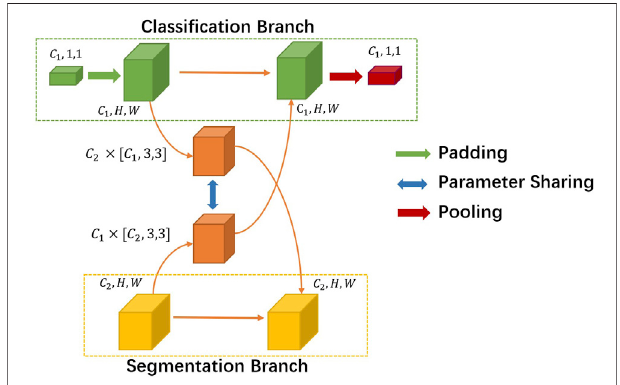
FIGURE 3 | Details of the cross fusion